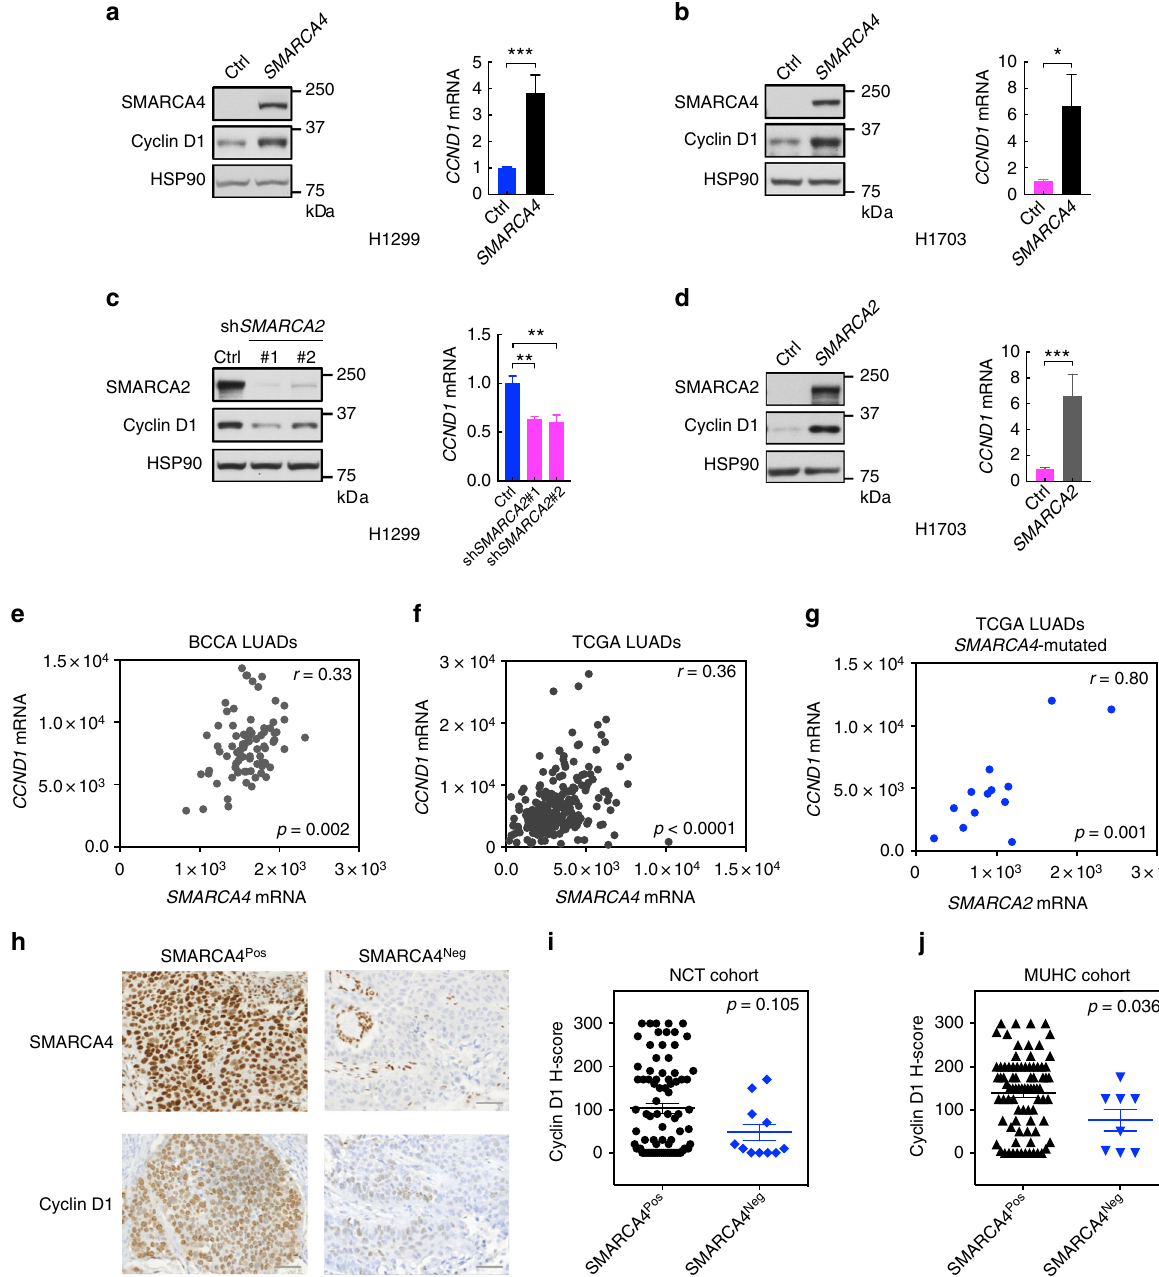
Fig. 3 SMARCA4/2 loss causes reduced cyclin D1 expression in non-small cell lung cancer (NSCLC). a – d SMARCA4/2 regulate cyclin D1 expression in NSCLC. a , b SMARCA4 restoration upregulates cyclin D1 protein (left) and messenger RNA (mRNA) (right) expression in H1299 ( a ) and H1703 ( b ) cells. c SMARCA2 knockdown in H1299 cells suppresses cyclin D1 protein (left) and mRNA (right) expression. d SMARCA2 restoration in H1703 cells elevates cyclin D1 protein (left) and mRNA (right) expression. Relative CCND1 mRNA expression (relative to GAPDH ) was measured by real-time quantitative reverse transcription PCR (RT-qPCR). Error bars: mean ± s.d. of biological replicates ( n = 3, two-tailed t -test, * p < 0.05, ** p < 0.01, *** p < 0.001). e , f Correlation of CCND1 and SMARCA4 mRNA expression in two cohorts of lung adenocarcinomas (LUADs) from BC Cancer Agency (BCCA; n = 83, e ) and The Cancer Genome Atlas (TCGA; n = 230, f ). g Correlation of CCND1 and SMARCA2 mRNA expression in SMARCA4-mutated LUADs ( n = 13) in the TCGA cohort. r , Pearson's correlation coef fi cient. h – j Immunohistochemistry (IHC) analysis of cyclin D1 protein expression in two cohorts of NSCLC patient tumors: NCT ( n = 93; h , i ) and McGill University Health Center (MUHC; n = 91; j ). Representative IHC images of SMARCA4 IHC-negative tumors are shown; a SMARCA4/2 IHC-positive tumor served as staining control ( h ). Cyclin D1 in IHC analysis was quanti fi ed with H-score and analyzed by